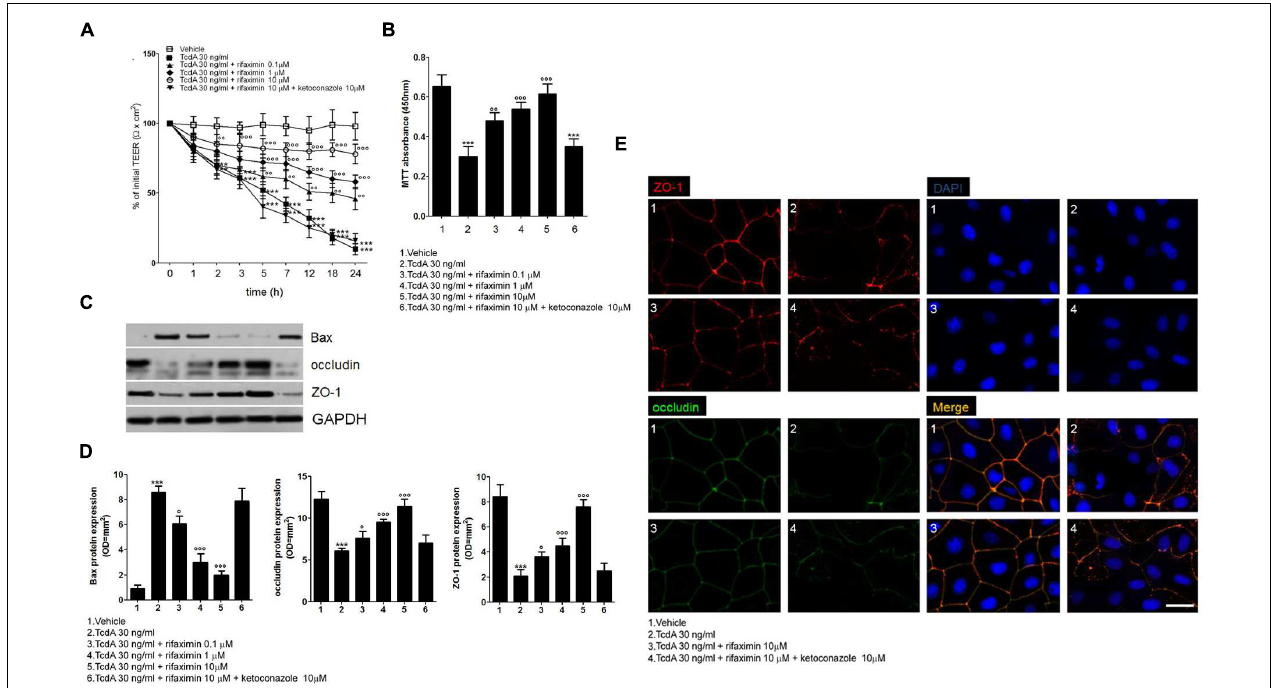
FIGURE 1 | Effects of increasing concentrations of rifaximin (0.1, 1.0, and 10 µ M) alone and rifaximin plus ketoconazole (10 µ M) against TcdA (30 ng/ml) in Caco-2 cells: (A) 24-h time course TEER changes ( n = 4); (B) MTT cell viability absorbance at 24 h ( n = 5); (C) Immunoreactive bands corresponding to Bax, ZO-1, and occludin expression at 24 h following the TcdA challenge; (D) Relative densitometric analysis of immunoreactive bands (arbitrary units normalized against the expression of the housekeeping GAPDH protein; n = 5), and (E) Immunofluorescent staining showing the effects of TcdA challenge on ZO-1 and occludin co-expression at 24 h. Nuclei were also investigated using DAPI staining (Scale bar = 25 µ m). Results are expressed as mean ± SEM of experiments performed in triplicate. ∗∗∗ p < 0.001 and ∗∗ p < 0.01 vs. vehicle group; ◦◦◦ p < 0.001, ◦◦ p < 0.01 and ◦ p < 0.05 vs. TcdA